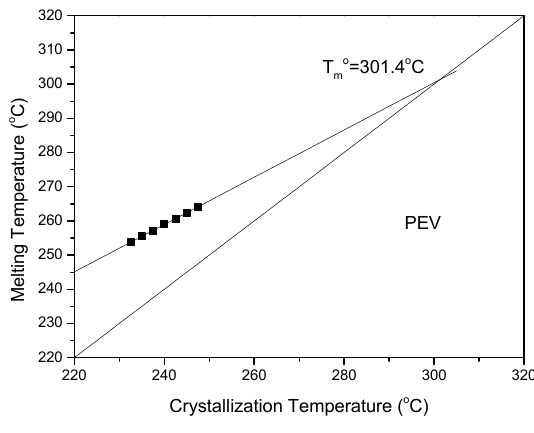
Figure 9. Hoffman-Weeks plot for PEV. Figure 9. Ho ff man-Weeks plot for PEV.